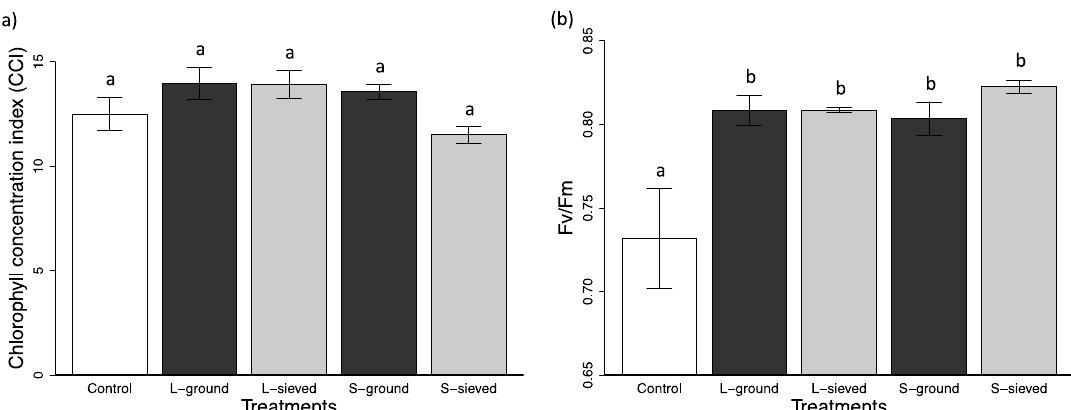
Figure 8. Chlorophyll concentration index (CCI) ( a ) and Fv/Fm (quantum efficiency of photosystem II) ( b ) of velvetleaf. Means are plotted ± 1 standard error based on measurements on 7 replicates for each treatment in velvetleaf. Within each panel, bars with the same lower case letters do not differ significantly at p < 0.05 according to Tukey’s HSD test.